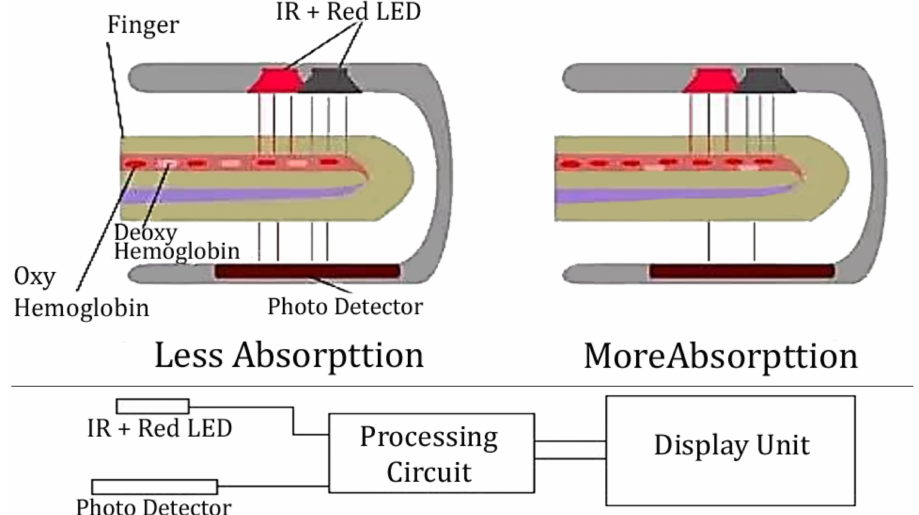
Figure 9. The structure of the pulse